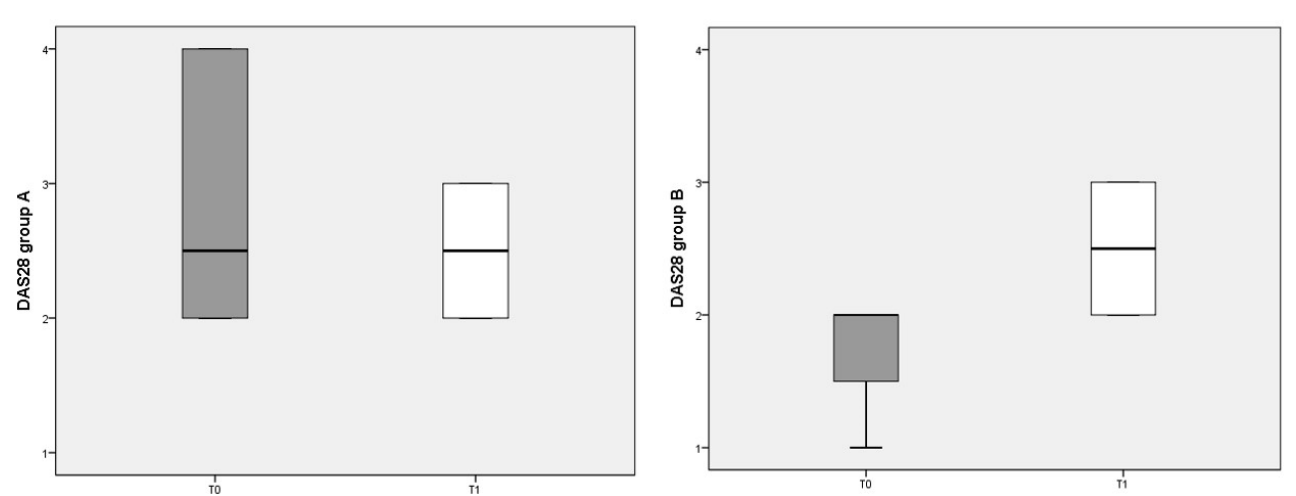
Figure 2. DAS 28 scores referred to different dietary regimens. Box plots represent the median and interquartile range of DAS 28 index in the two groups (A and B diets).